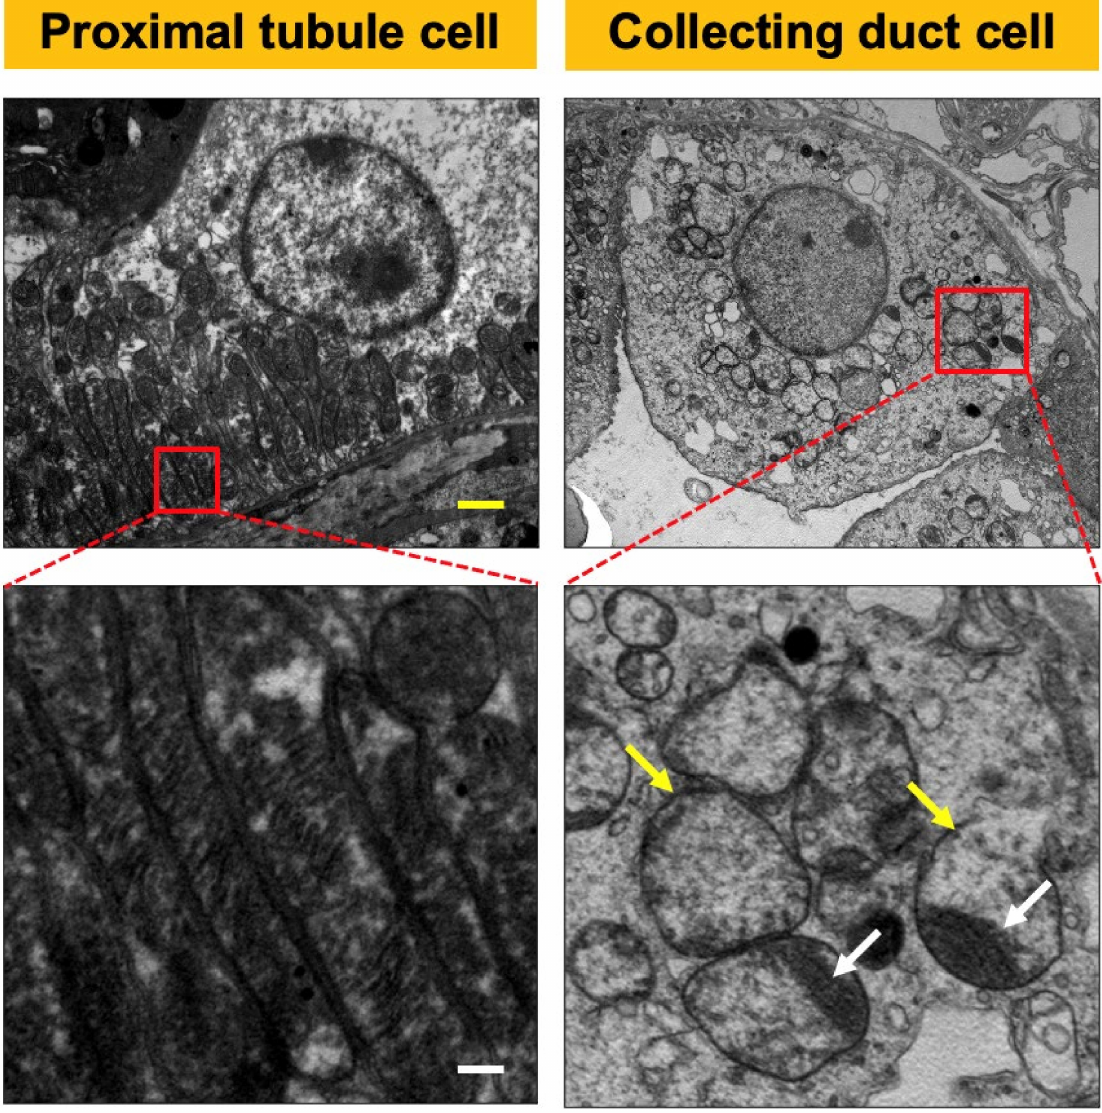
Figure 2. Photos of electron microscopy of CR6-interacting factor-1 knockout (CRIF1-KO) sham mouse kidney. The mitochondria of collecting duct cells were swollen (white arrow) and showed the destruction of cristae (yellow arrow) in the kidneys of CRIF1-KO mice. The mitochondria of proximal tubular cells showed normal morphology in CRIF1-KO mice. Yellow scale bar, 2 µ m. White scale bar, 0.2 µ